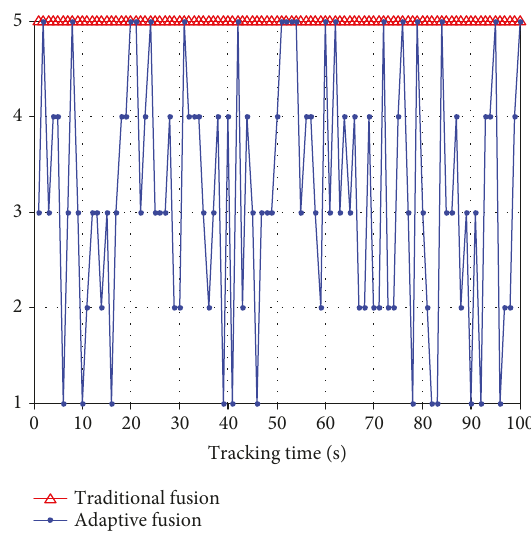
Figure 3: Working radar